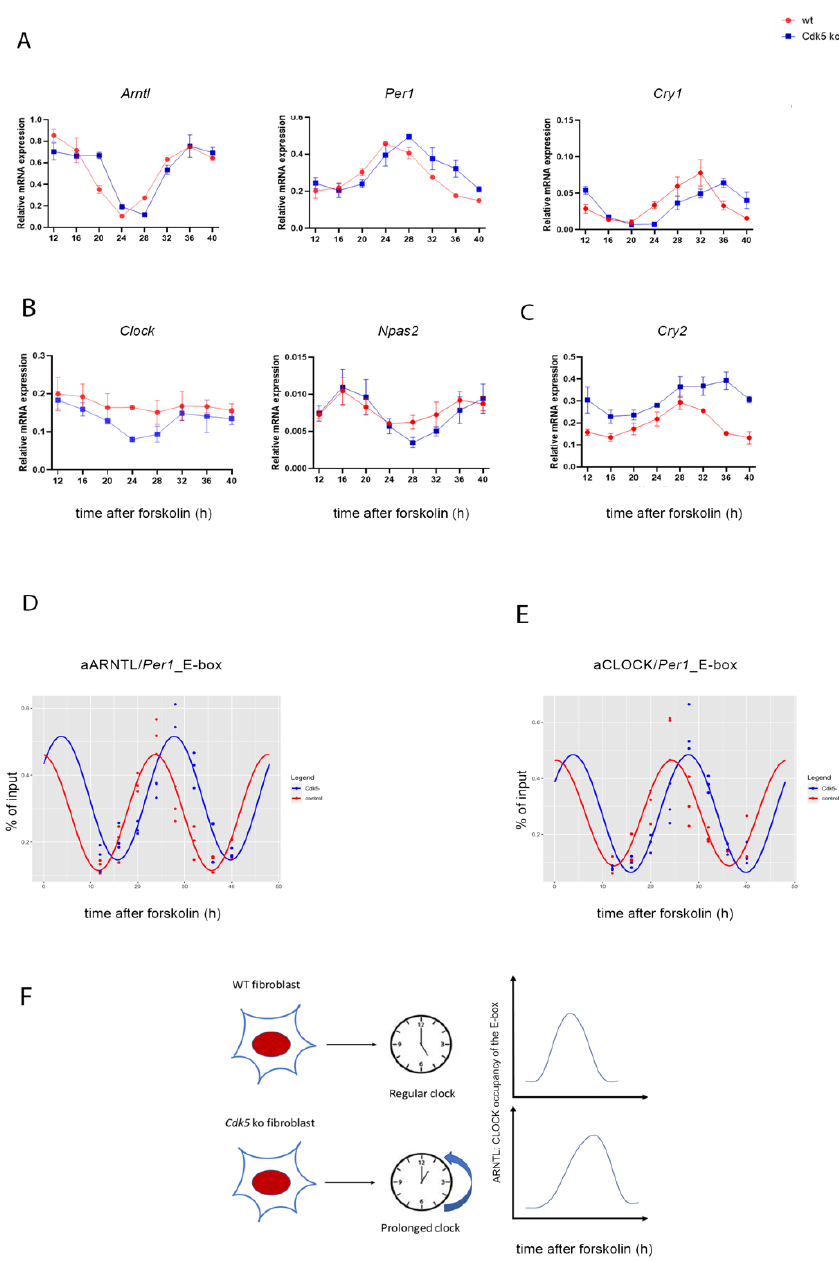
Figure 5. CDK5 influences the expression of clock-controlled genes and affects CLOCK: ARNTL (BMAL1) promoter occupancy. ( A – C ) The temporal profile of mRNA accumulation of many clock- controlled genes was analyzed in synchronized wild-type and Cdk5 ko cells. Quantification of three independent experiments ( n = 3, mean ± SD) was performed. One-way ANOVA with Bonferroni’s post-test, *: p < 0.001. Chromatin immunoprecipitation was performed using ARNTL ( D ) or CLOCK ( E ) antibody as bait. RT-qPCR was performed using specific probes that amplified the E-box region of Per1 . Quantification of three independent experiments ( n = 3, mean ± SD) was performed. Rhythmicity was analyzed using CircaCompare [31]. For ARNTL [ ∆ ( Cdk5 ko-wt]: ∆ mesor = − 0.043 (AU, n.s.); ∆ amplitude = − 0.011 (AU, n.s.); ∆ phase = − 4.04 (h, p < 0.001). For CLOCK [ ∆ ( Cdk5 ko-wt]: ∆ mesor = − 0.002 (AU, n.s.); ∆ amplitude = − 0.018 (AU, n.s.); ∆ phase = − 3.49 (h, p < 0.001). ( F ) Summary showing that lack of CDK5 can prolong the period length, delay ARNTL and CLOCK recruitment to E-boxes, and affect circadian gene